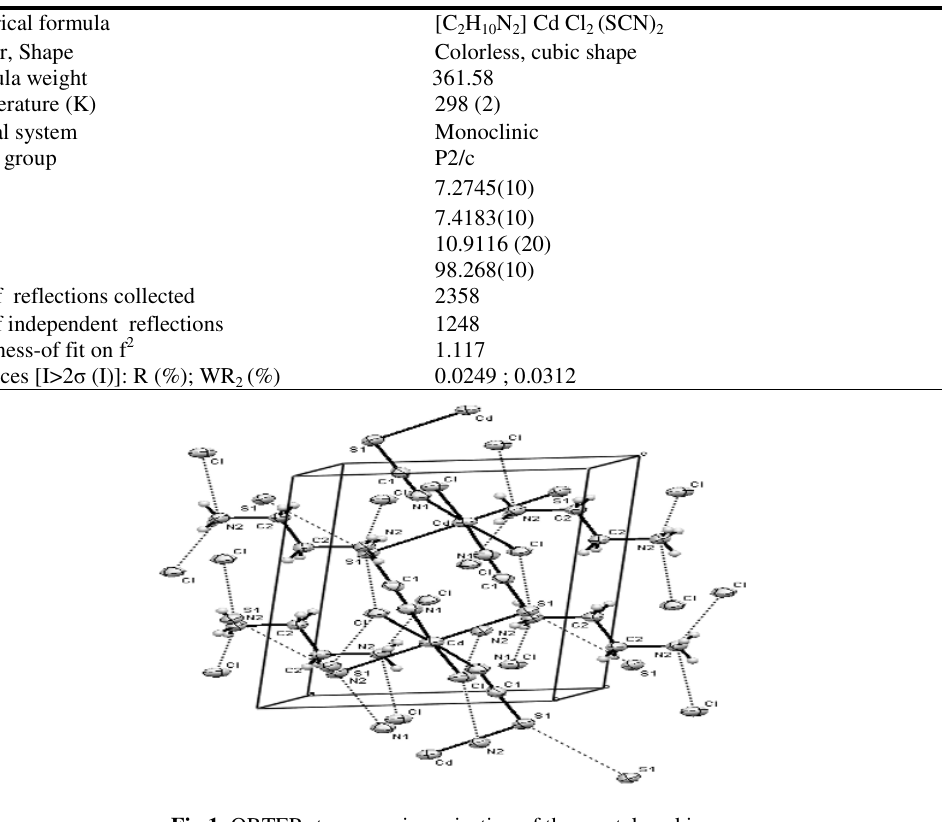
Table 1. Crystal data and structure refinement for [C